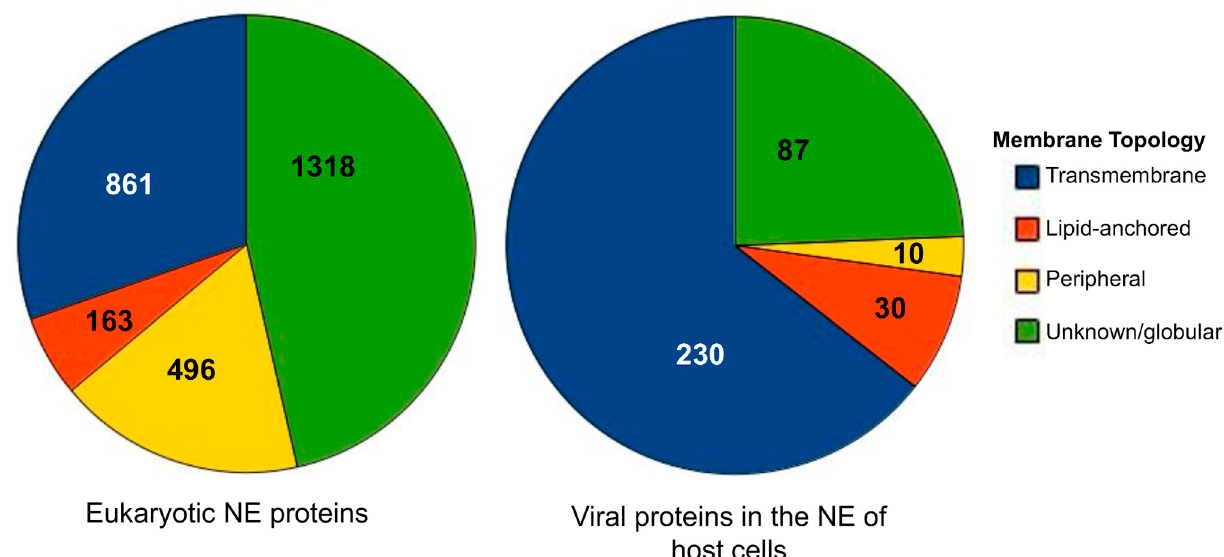
Figure 1. Distribution of NuEnvDB entries among membrane topology categories for nuclear enve- lope proteins ( left ) and viral proteins located at the NE of host cells ( right ). Each topology category corresponds to a different color (blue for transmembrane, red for lipid-anchored, yellow for periph- eral, and green for unknown/globular proteins).